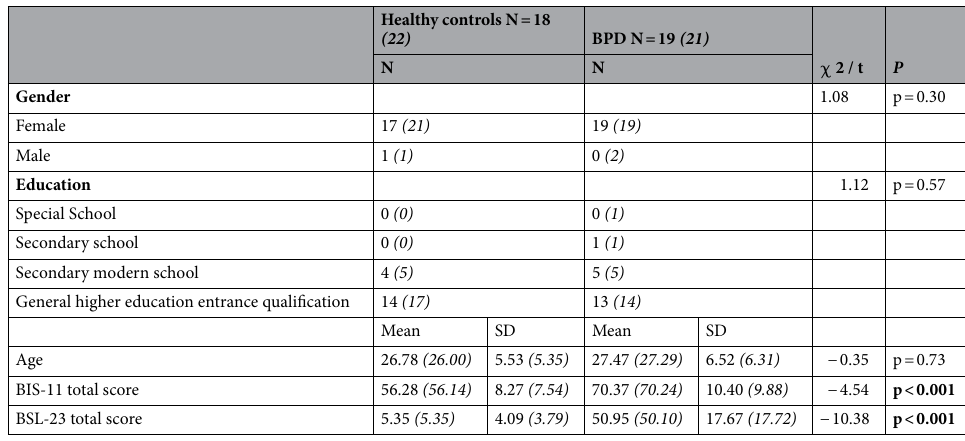
Table 3. Characteristics of the two participant groups. BPD borderline personality disorder, BIS-11 Barratt Impulsiveness Scale, BSL-23 Borderline Symptom List.